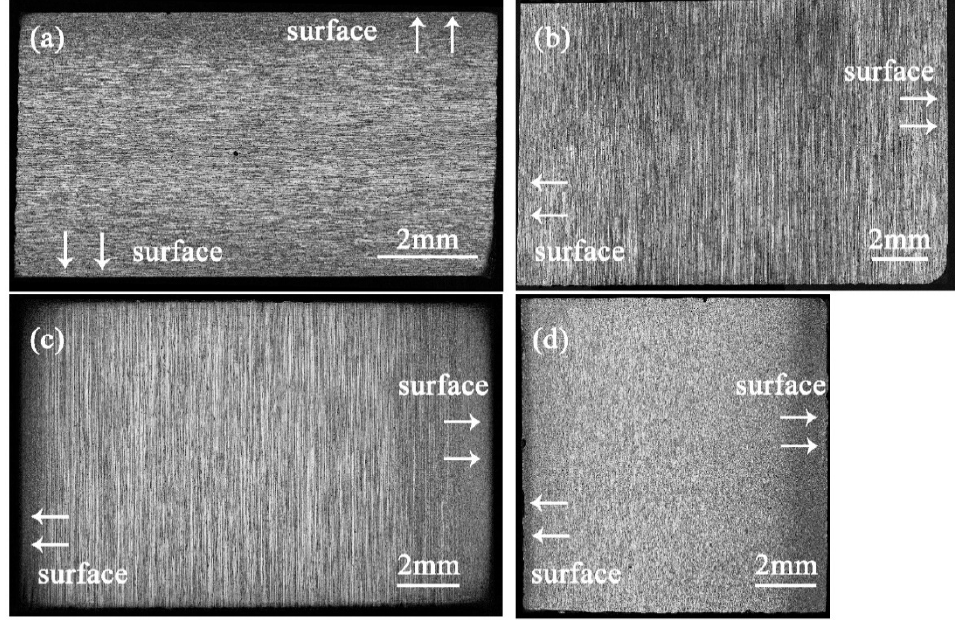
Figure 10. The surface morphology and grayscale of the four aluminum alloy sections after corrosion: ( a ) T4-6; ( b ) T4-15; ( c ) T5-15; ( d ) T5-10.